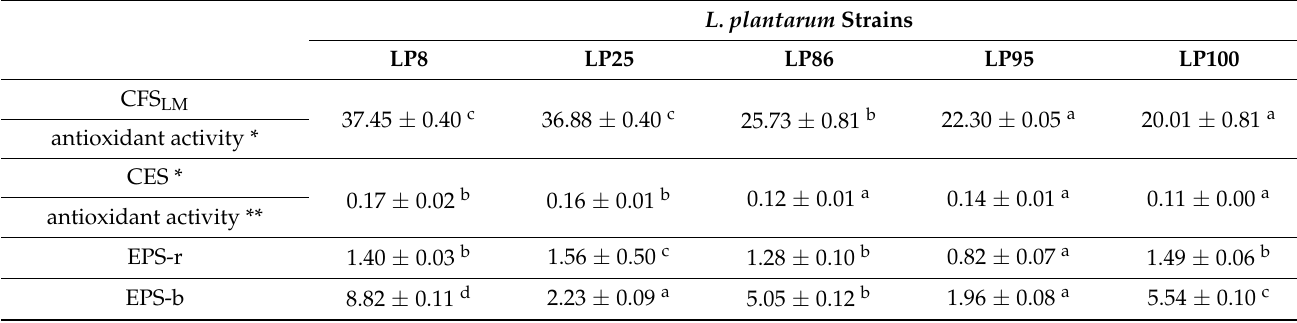
Table 1. EPS production in MRS medium after 48 h and antioxidant activity in LM medium of L. plantarum LP8, LP25, LP86, LP95 and LP100 strains. All values are expressed as mean ± standard deviation (n = 3). Different lowercase letters (a–c) in each row indicate significant differences ( p < 0.05).